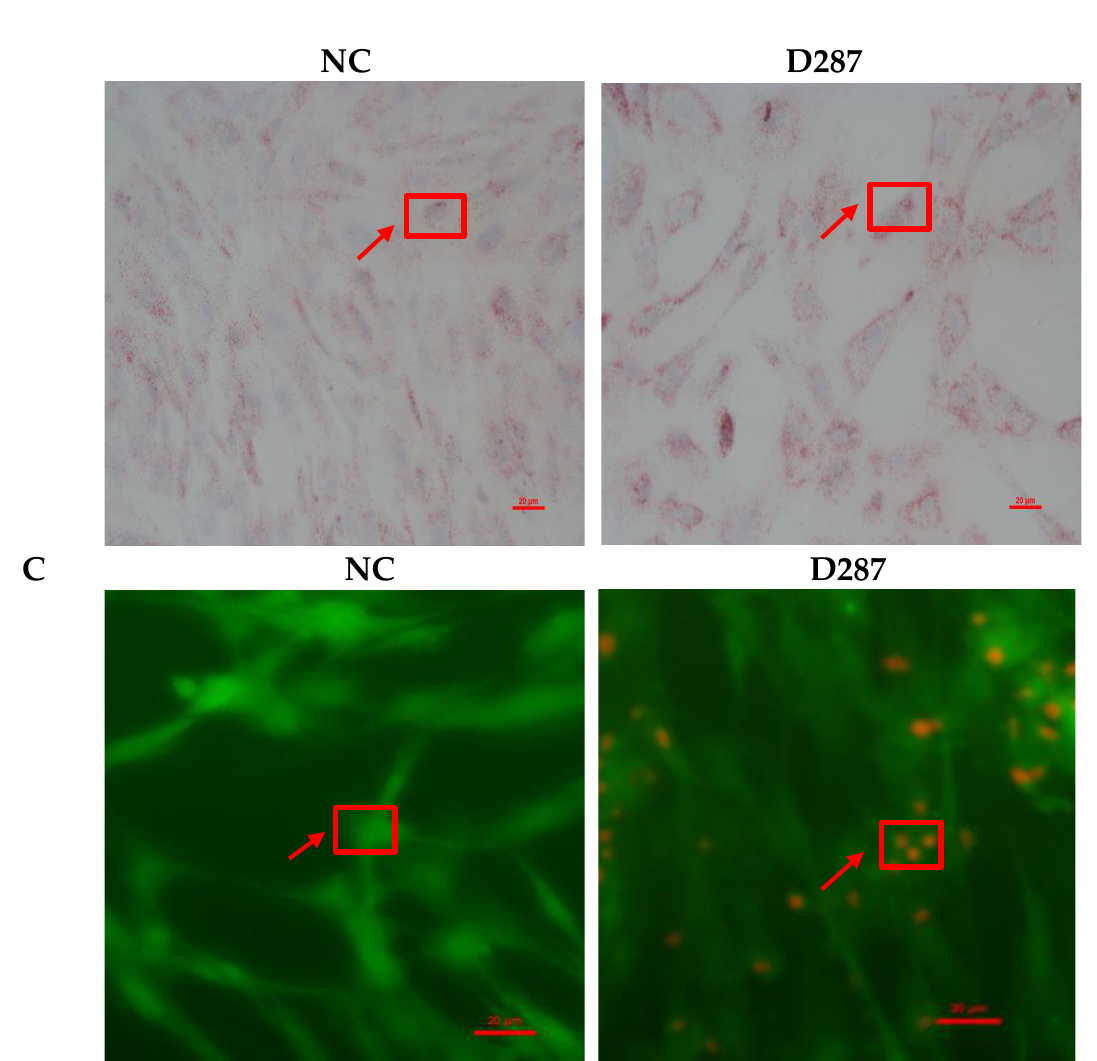
Figure 2. shRNA interference of DDIT3 and its effect on MAC-T cells. Note : ( A ) The shRNA interference effects of LV3-DDIT3-D287 in MAC-T cells. ( B ) Lipid accumulation of NC and LV3-DDIT3-D287 groups in MAC-T cells by Oil Red O staining; NC-versus Ctrl group and D287-LV3-DDIT3-D287 group. ( C ) Calcein-AM/PI staining assays.